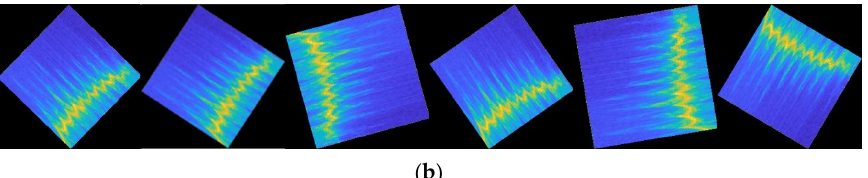
Figure 7. The image augmentation technique applied on the gait biometric: ( a ) a sample RGB image; ( b ) the resulting images after applying the random 2D affine function.